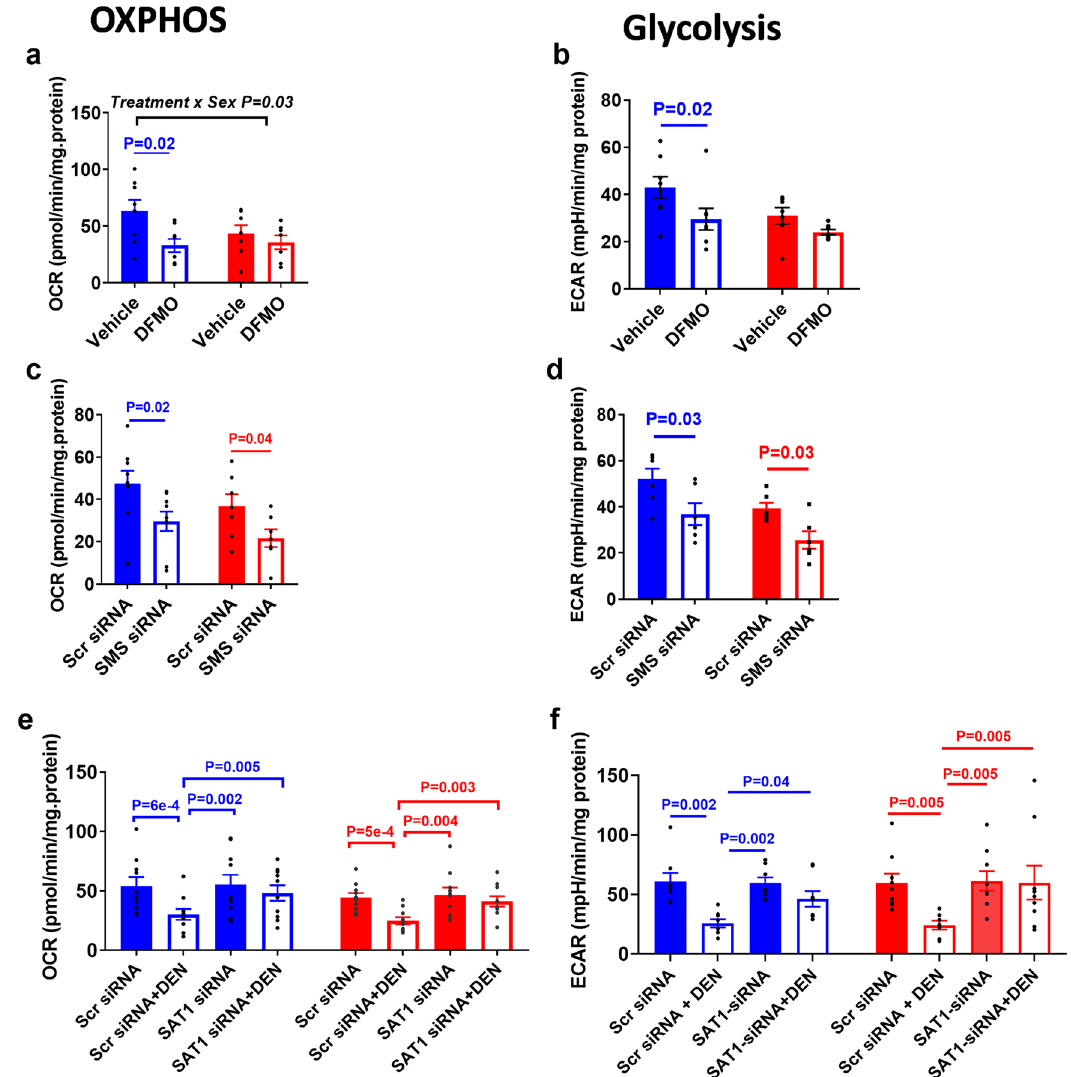
Fig. 4 Suppression of cellular energy metabolism by polyamine depletion. Polyamine depletion by DFMO decreases ( a ) OXPHOS and ( b ) glycolysis in male PHTs. Inhibition of spermine synthesis by SMS-silencing decreases ( c ) OXPHOS and ( d ) glycolysis in both male and female PHTs. Induction of SSAT- mediated polyamine catabolism by DENSPM decreases ( e ) OXPHOS and ( f ) glycolysis in both male and female PHTs. Bar graphs show mean±SEM, N = 8 – 10 male PHTs and N = 8 – 10 female PHTs. OCR oxygen consumption rate; ECAR extracellular acidi fi cation rate; were measured on a Seahorse